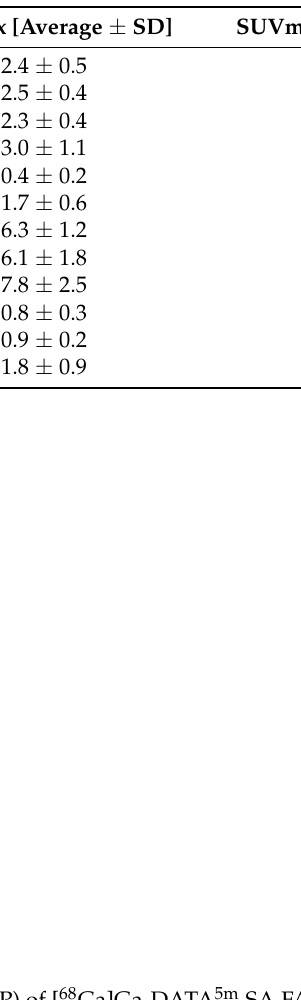
Table 1. Physiological uptake (SUV max and SUV mean ) of the tracer [average ± SD] in selected organs and tissues.